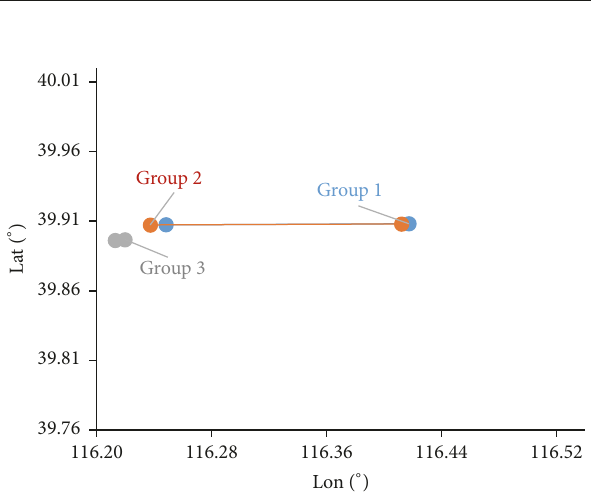
Figure 2: Example of cluster results of departure and arrival stations